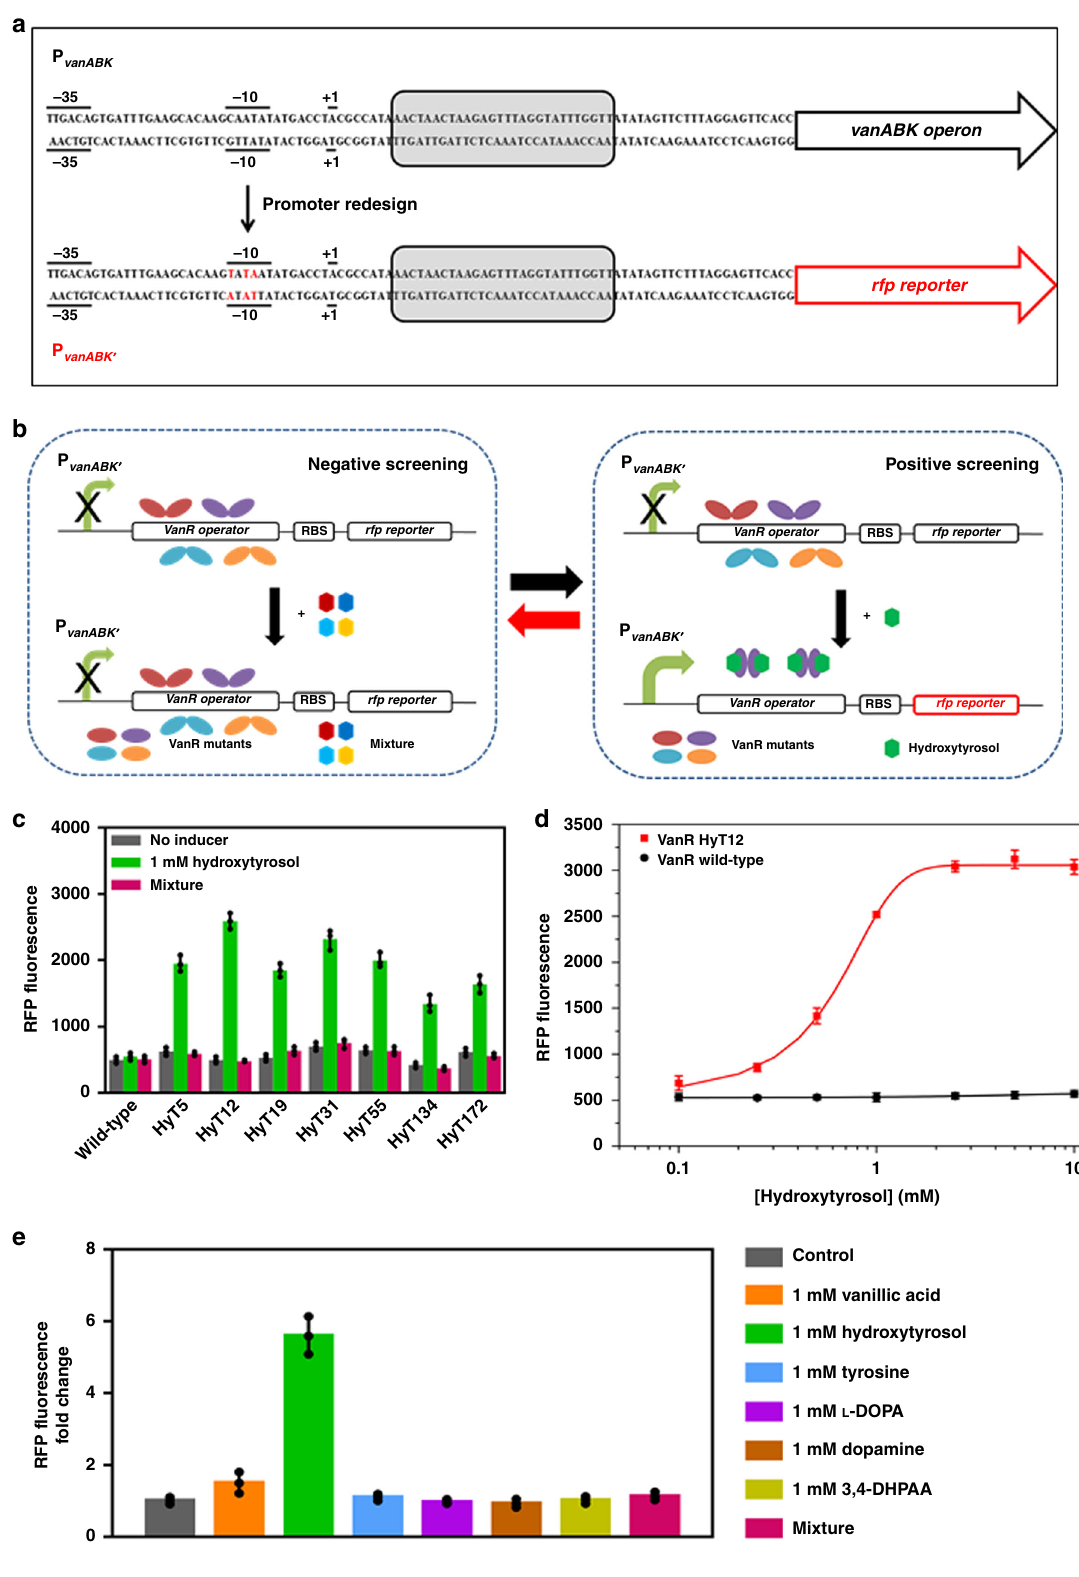
fl uorescent cells (2.8 × 10 5 ) in the presence of 1 mM each of tyrosine, L -DOPA, dopamine and 3,4-DHPAA, in order to remove the VanR variants responsive to the substrate and intermediates in hydroxytyrosol biosynthesis. One round of